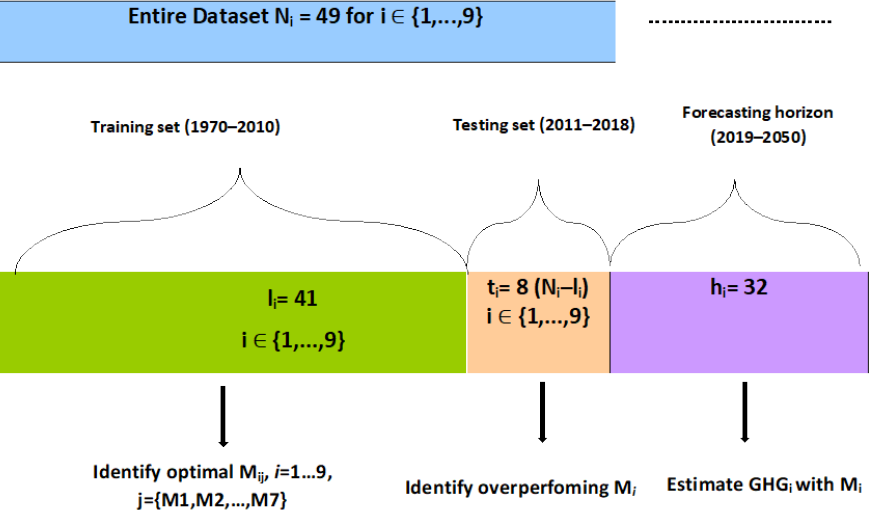
Figure 5. The holdout period forecasting method.